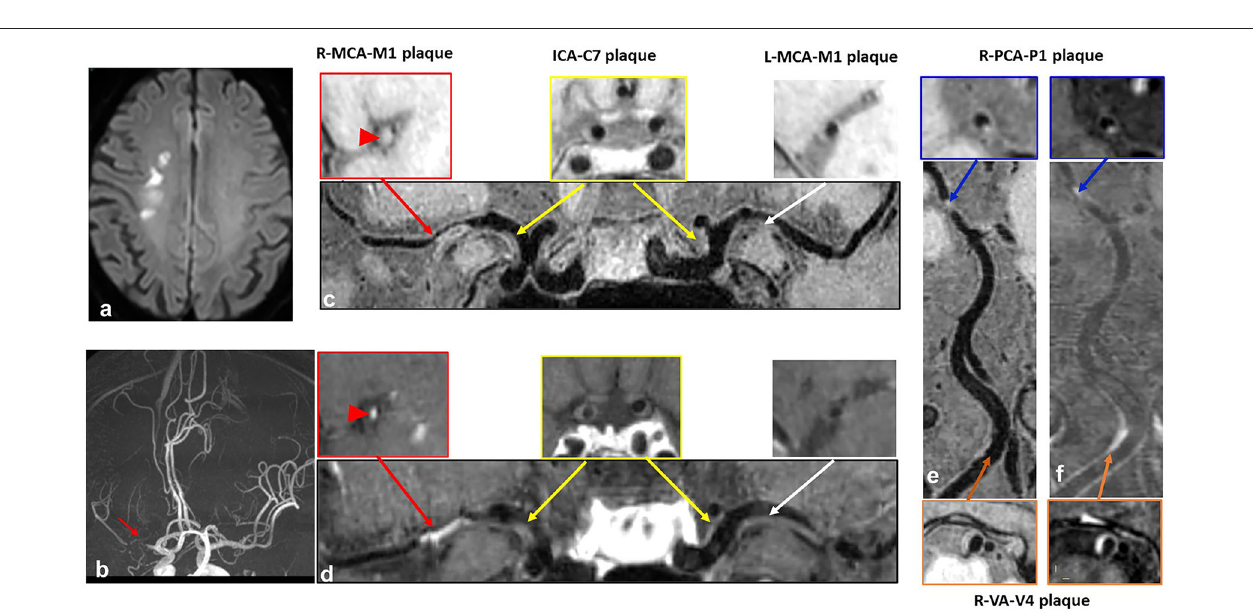
Frontiers in Aging Neuroscience |